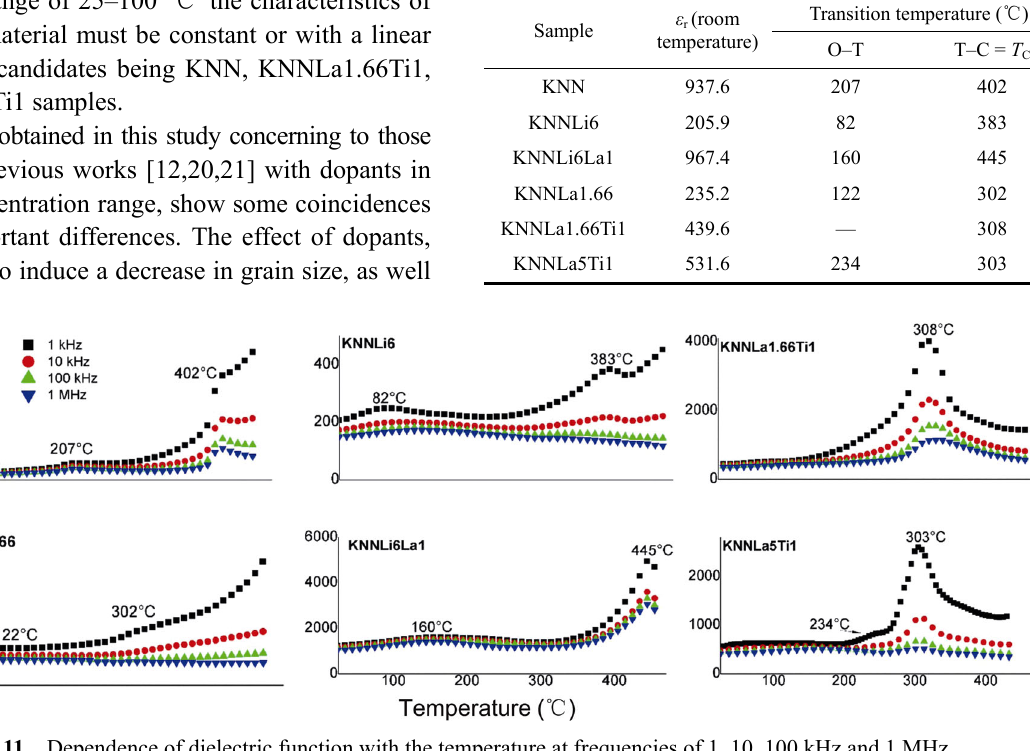
Fig. 11 Dependence of dielectric function with the temperature at frequencies of 1, 10, 100 kHz and 1